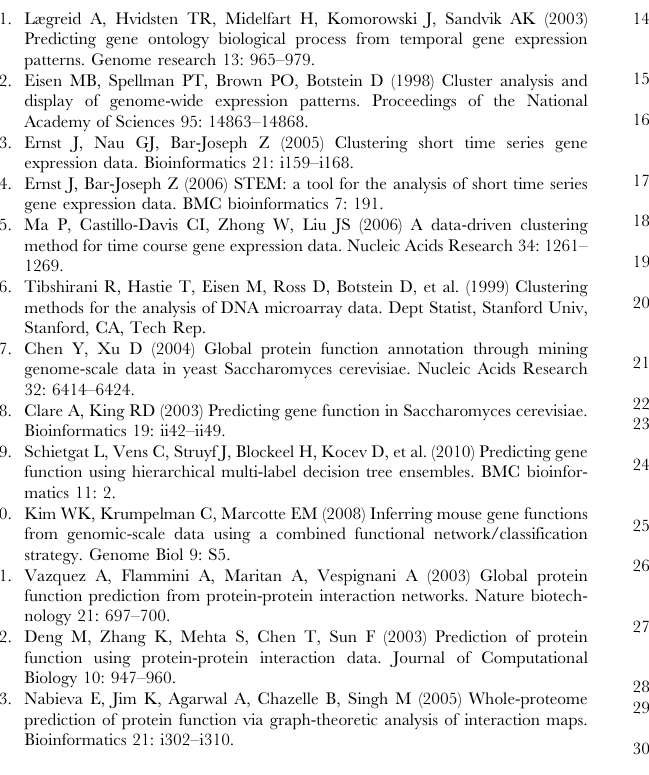
Table S3 Average TPR and FPR obtained from the cdc28 dataset by MLKNN. Table S4 Average TPR and FPR obtained from the cdc28 dataset by MLSVM. Table S5 Average TPR and FPR obtained from the cdc15 dataset by MLKNN. Table S6 Average TPR and FPR obtained from the cdc15 dataset by MLSVM. Table S7 Average TPR and FPR obtained from the alpha dataset by MLKNN. Table S8 Average TPR and FPR obtained from the alpha dataset by MLSVM. Table S9 Average TPR and FPR obtained from the elution dataset by MLKNN. Table S10 Average TPR and FPR obtained from the elution dataset by